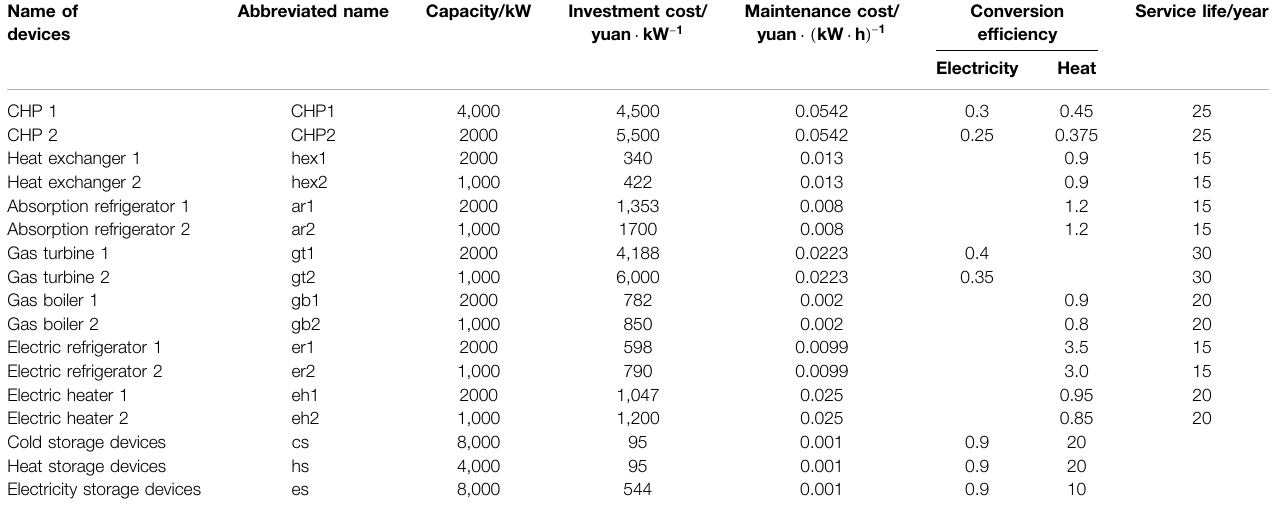
TABLE 2 | Economic parameters of IES